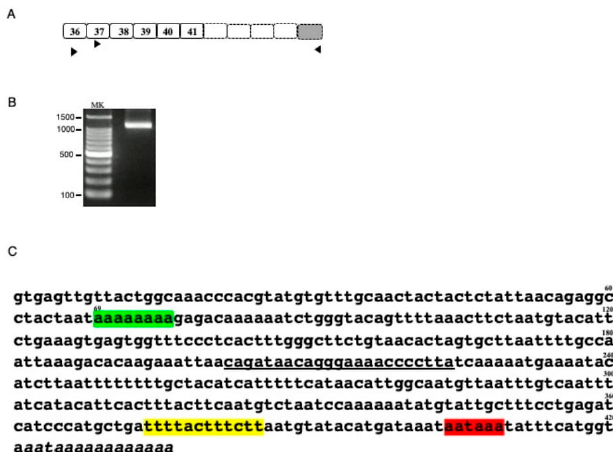
Figure 1. Characterization of the 3 ′ truncated DMD transcript ( A ) Schematic description of putative 3 ′ truncated DMD transcript. The exon structure of the putative 3 ′ truncated DMD transcript is shown schematically. Although previous DMD transcript analysis of U-251 cells suggested a transcript ending at exon 41, exons 42, 43, 44 and 45 were not known. Boxes and numbers in the boxes indicate exons and exon numbers, respectively. Dot lined and shaded boxes indicated unclarified DMD and the 3 ′ terminal exon, respectively. Horizontal arrowheads indicate the location and direction of the universal amplification primer and the exon specific forward primers on exons 36 and 37 used for 3 ′ RACE. ( B ). Product amplified by 3 ′ RACE. The semi-nested product amplified by 3 ′ RACE is shown. A clear band was observed between the 1000 and 1500 bp size markers. MK refers to the size marker (100 bp ladder). ( C ) Sequence of the 3 ′ RACE product. Sequencing of the 3 ′ RACE product revealed sequences corresponding to exons 37, 38, 39, 40 and 41. Downstream of exon 41, however, the exon 42 sequence was replaced by an ambiguous nucleotide sequence, as shown. The 421 bp sequence matched the 5 ′ end sequence of intron 41, with the 3 ′ end not matching the genomic sequence, indicating a poly(A) tail. In this sequence, however, 2 A nucleotides were missing compared with the reference sequence (green box). The 3 ′ end contained a polyadenylation signal (aataaa) 13 bp upstream from the poly (A) tail (red box), with a poly U element 19 bp upstream from the poly(A) signal (yellow box). The underlined sequence indicates the binding site for the primer used to amplify the novel transcript.